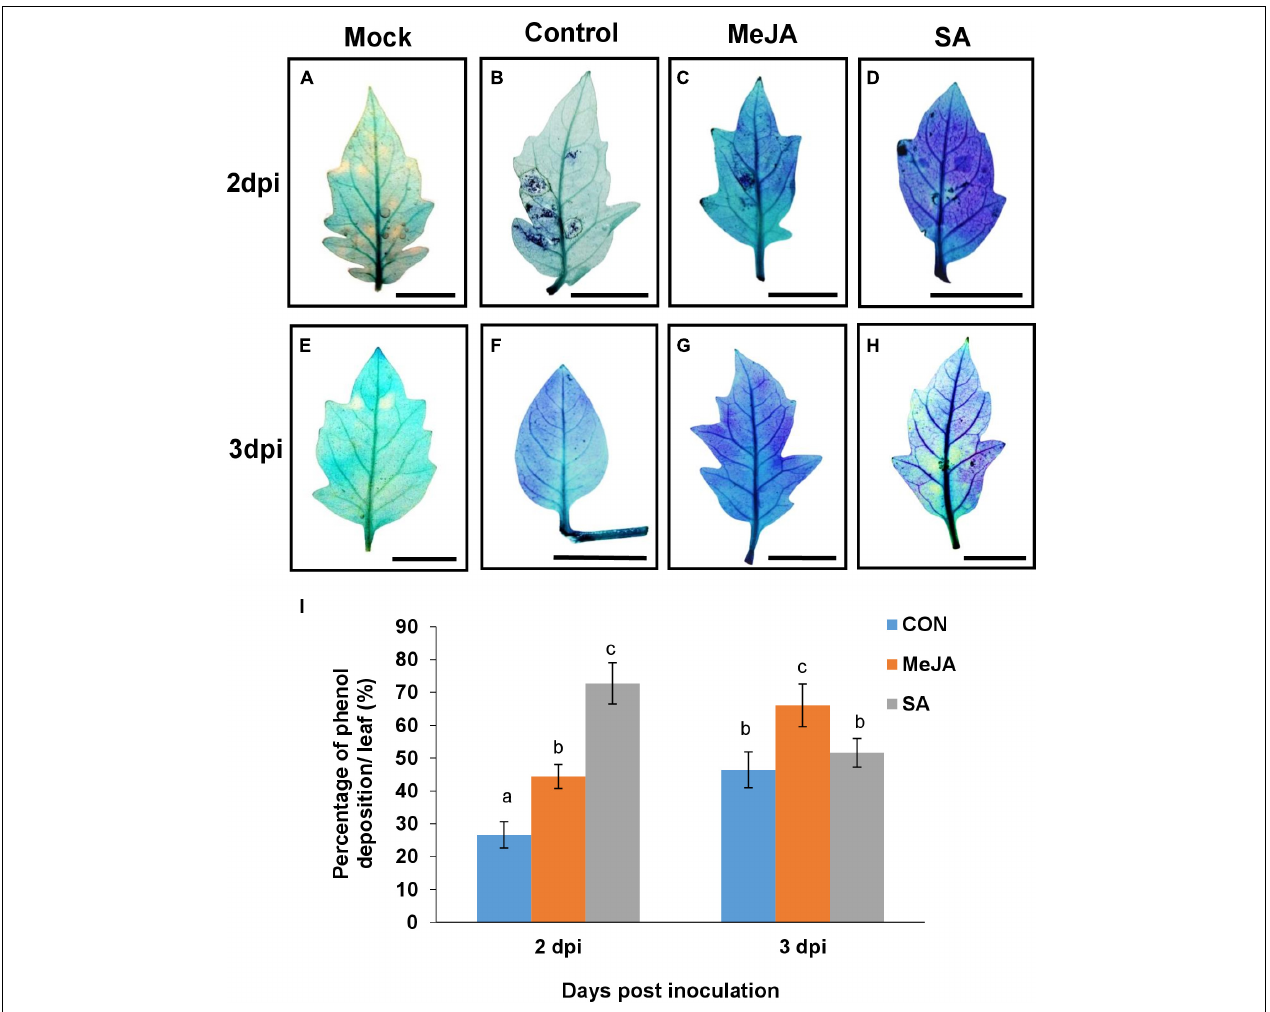
FIGURE 11 | Accumulation of phenol detected by toluidine blue shows that SA priming resulted in more deposition in earlier phase of infection while MeJA priming in the later phases. (A–H) The development of blue color indicate the amount of phenol in leaves of different sets of control and primed leaves at 2 and 3 days post infection. (I) Graph representing the comparison of the above result. Bars represent mean ± S.E.M of six independent experiments. Different letters indicate significant differences among treatments at p < 0.05, according to Duncan’s multiple range test. Bar = 30